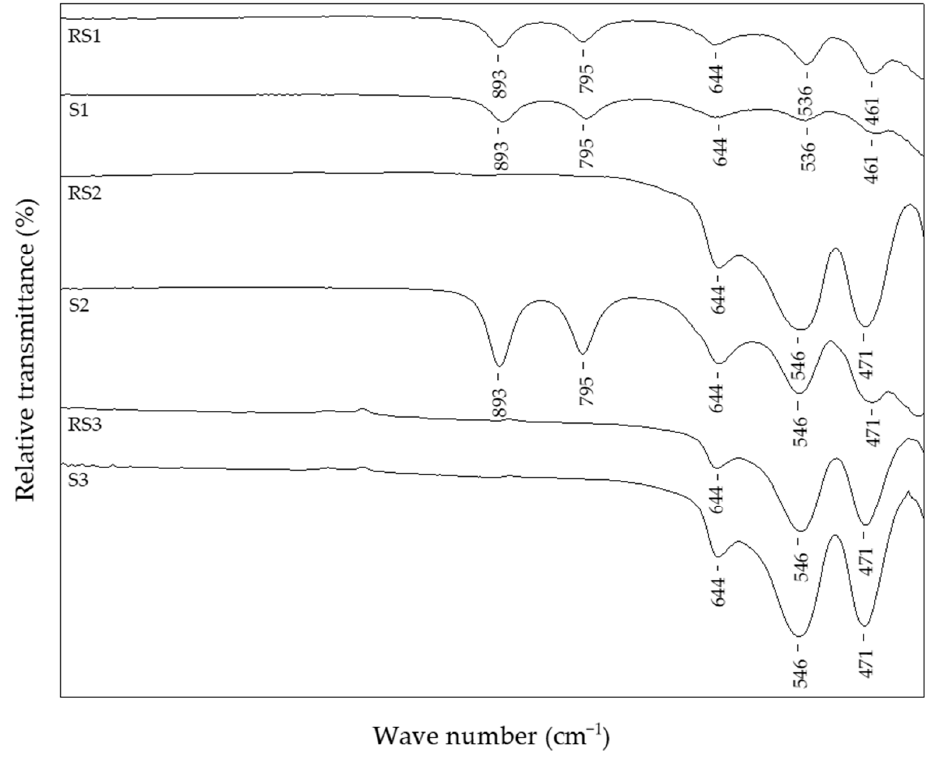
Figure 1. FT-IR spectra of reference samples and samples with 1%